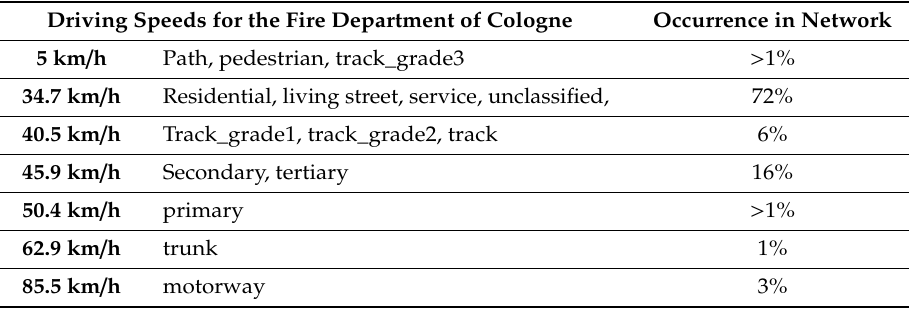
Table 3. Driving speeds for planning purposes of the fire department of Cologne